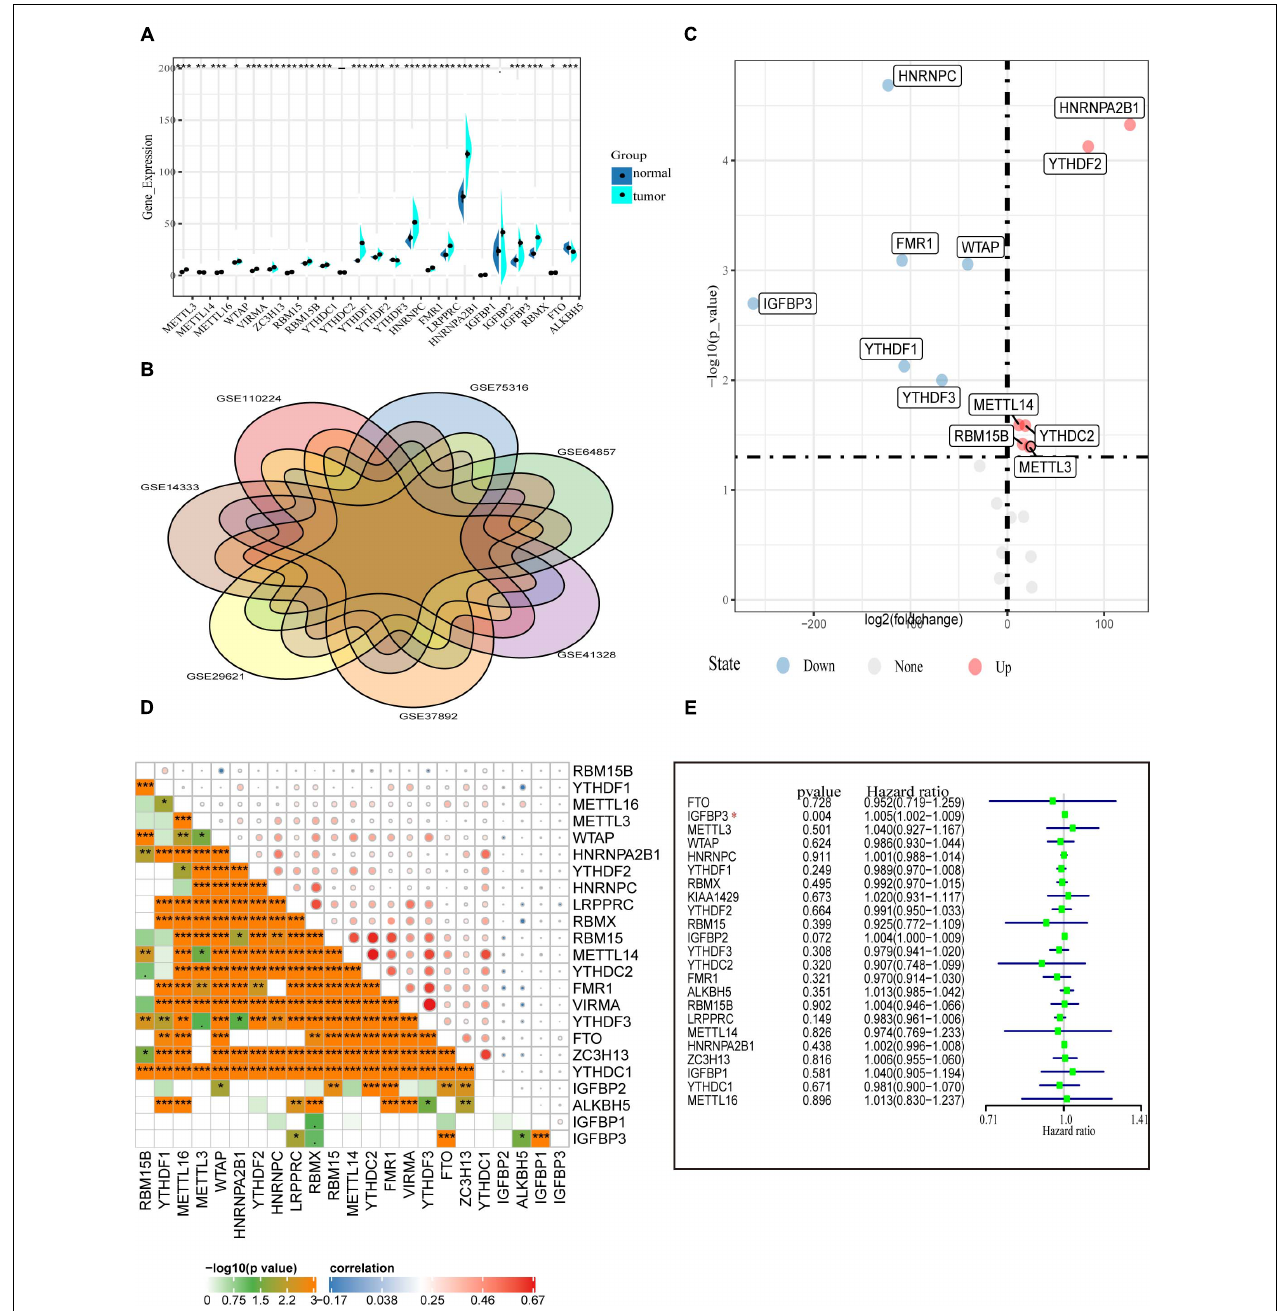
FIGURE 1 | Transcriptome profiles of m6A RNA methylation regulators in COAD. (A) Differential expression of m6A RNA regulators between 473 tumor tissues and 41 normal tissues in the TCGA-COAD cohort. (B) The presence of batch effects in COAD data in the GEO data set. (C) Normalized GEO data for differential expression of m6A RNA genes between 652 tumor and 27 normal tissues. (D) The correlation of the m6A regulatory genes in the TCGA-COAD cohort. (E) Forest plot of the prognostic ability of the m6A RNA methylation regulators in the TCGA-COAD